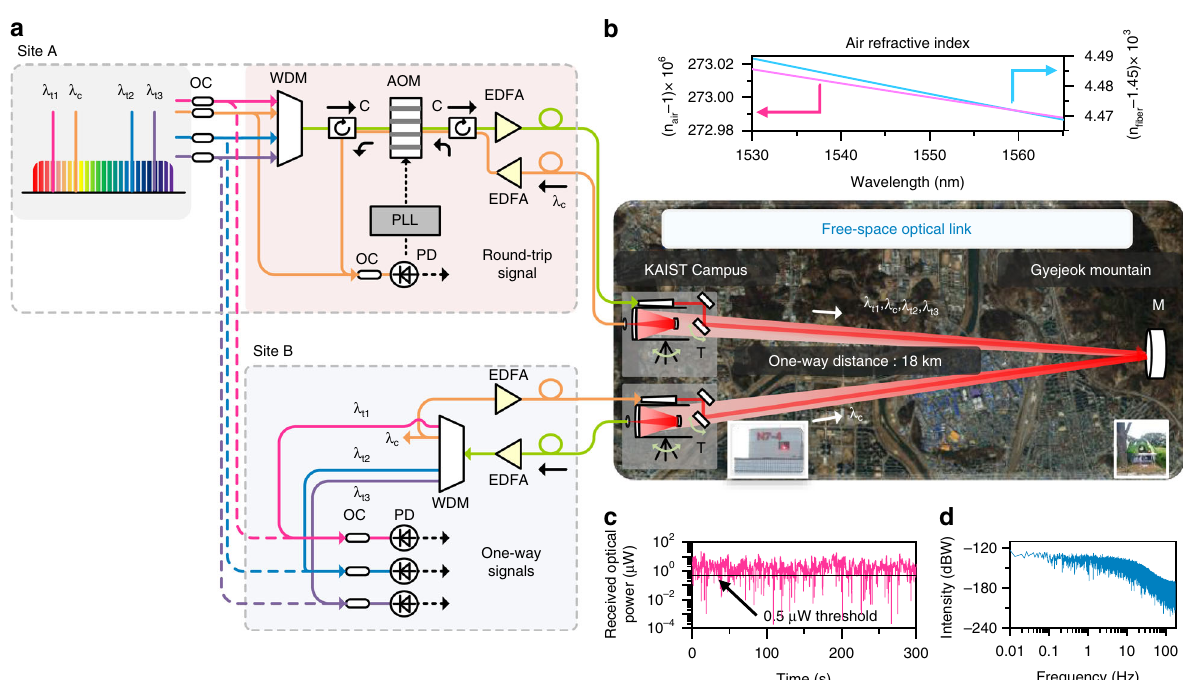
Fig. 1 Phase-coherent transfer of comb-rooted optical frequencies over an 18-km free space link. a Multiple optical carriers are extracted from a frequency comb in stabilization to a high- fi nesse cavity and transmitted from Site A to Site B. The second carrier λ c is selected as the feedback compensation channel of atmospheric optical phase noise, while other carriers λ t1 , λ t2 and λ t3 are dedicated channels for optical frequency transfer. b Refractive indices of air and fi ber in the infrared range are compared in the inset. c Optical power scintillation at Site B observed at a sampling rate of 3 ms over an interval of 300 s. d Scintillation frequency spectrum. AOM acousto-optic modulator, C optical circulator, EDFA erbium-doped fi ber ampli fi er, PLL phase-locked loop, T telescope, M fl at mirror, OC optical coupler, PD photodetector, WDM wavelength division